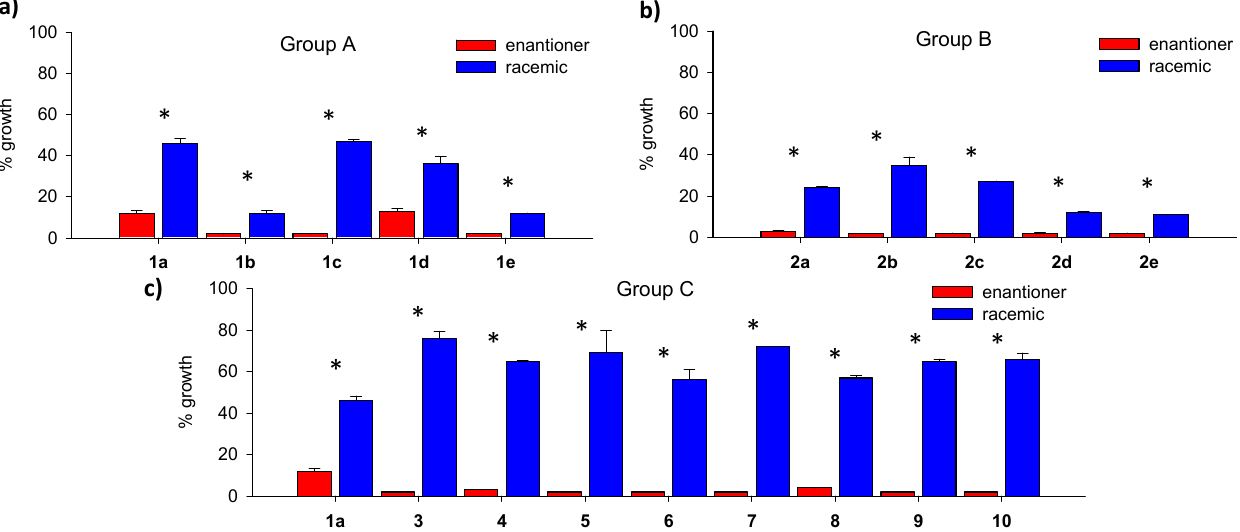
Figure 3. Comparative values of the inhibitory activities of antifungal succinimides in their enantiomeric and racemic forms (at 125 μ g/mL) expressed as percentage of growth against Candida albicans ATCC 10231. * p <